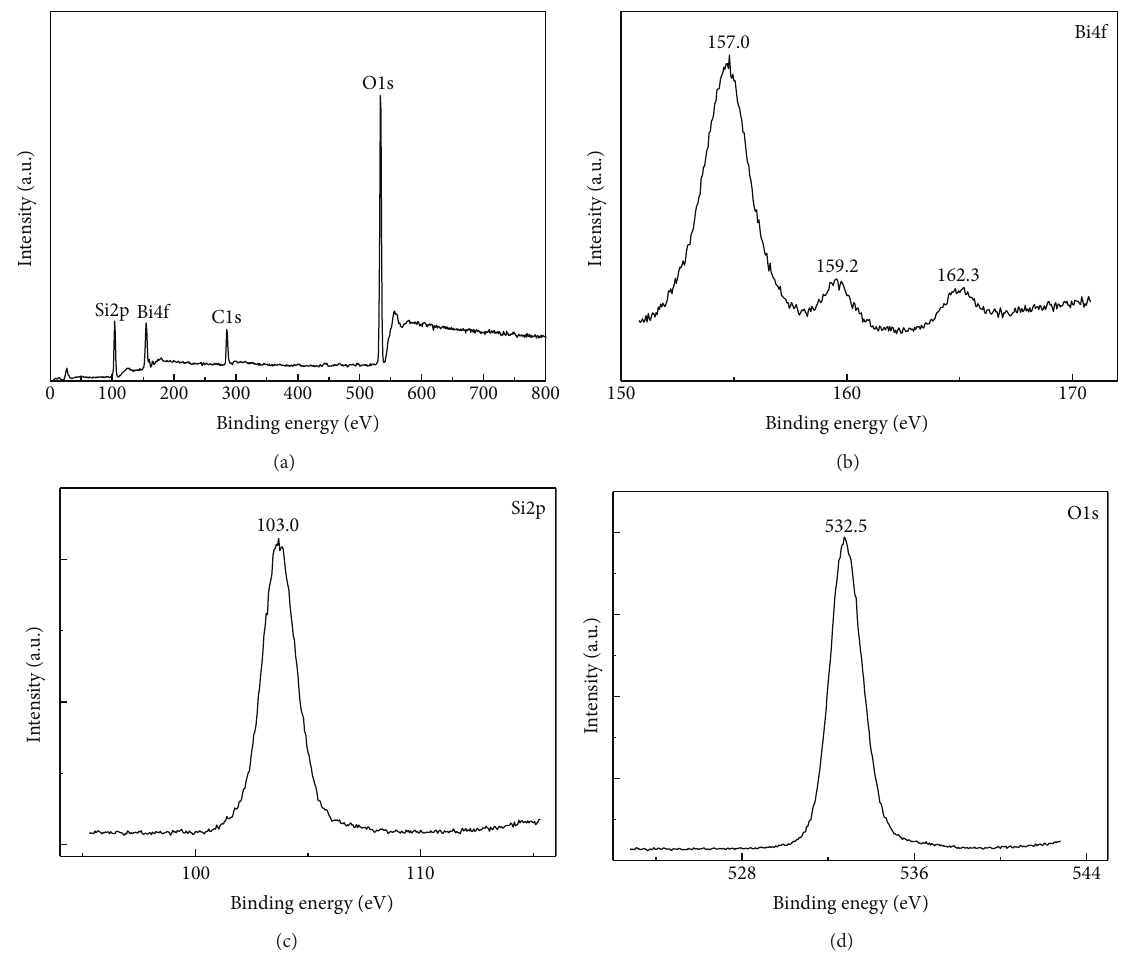
Figure 5: X-ray photoelectron spectra of 550-4: (a) XPS spectrum; (b) Bi4f spectra; (c) Si2p spectra; (d) O1s